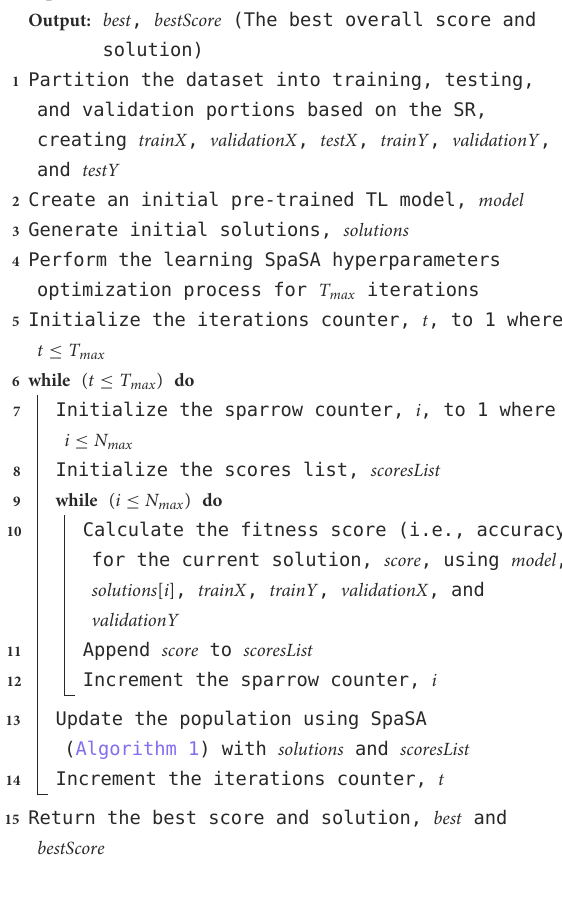
Algorithm 2. Pseudocode for the proposed DRDC framework.